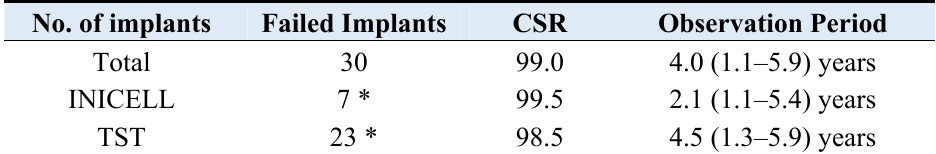
Table 1. Statistical comparison of the INICELL and TST survival rates (Fisher’s exact test; * p < 0.01).